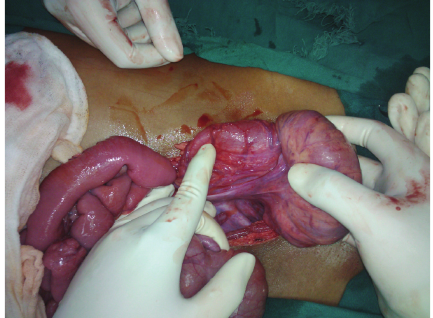
Figure 3: Intussusception being reduced intra-operatively.